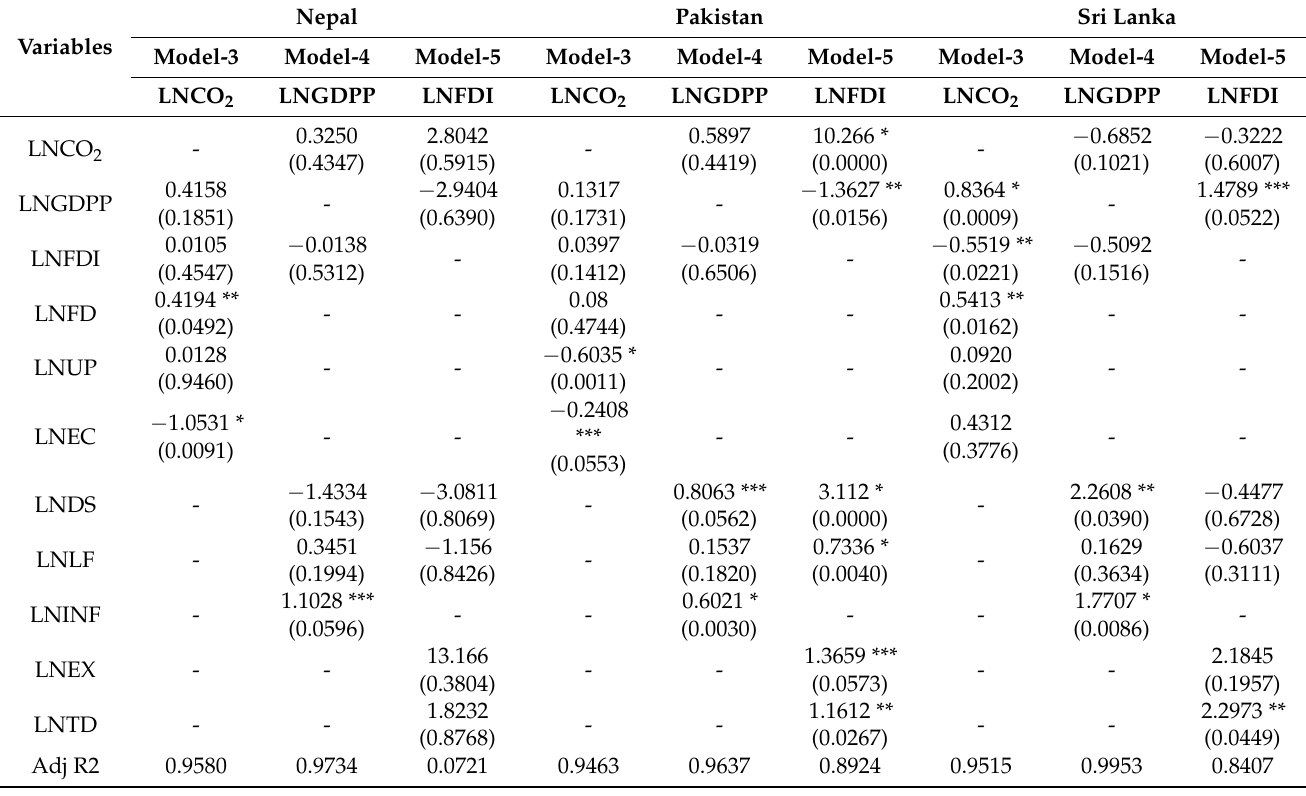
Table 6. Results for the Individual Countries. Nepal, Pakistan, and Sri Lanka.